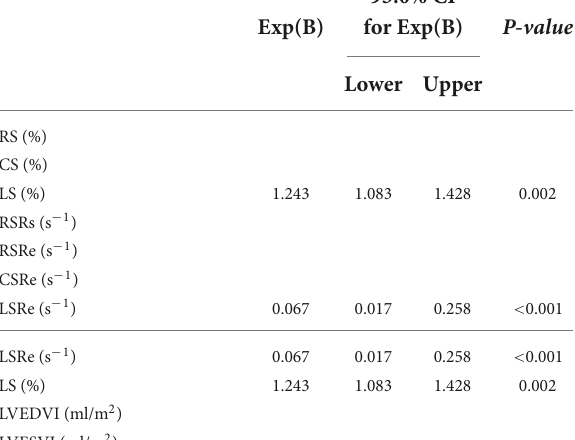
TABLE 5 Multiple multivariable Cox to evaluate the associations of clinical and cardiac magnetic resonance (CMR) characteristics with adverse